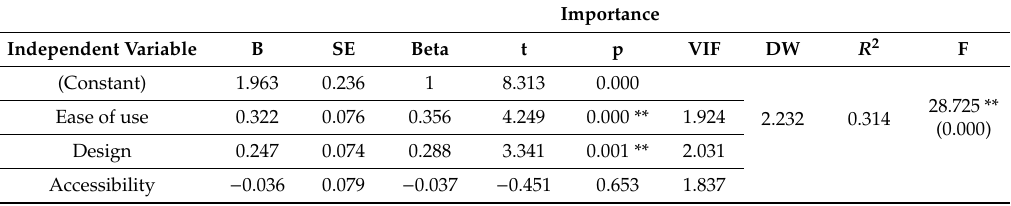
Table 8. E ff ect of system on the importance of the recommendation